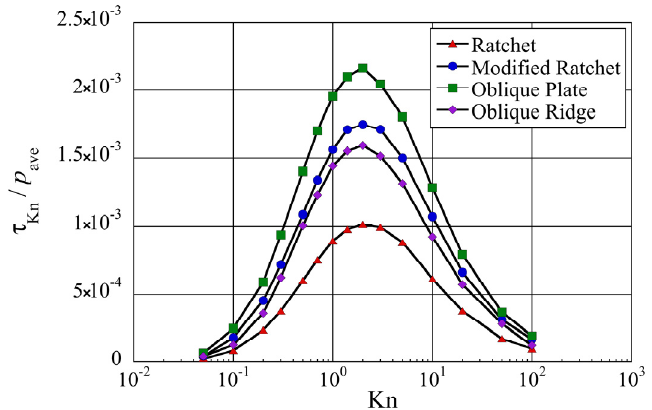
Figure 10. Net tangential Knudsen stresses, i.e., propulsive forces per unit area, at different Knudsen numbers for different surface microstructures.